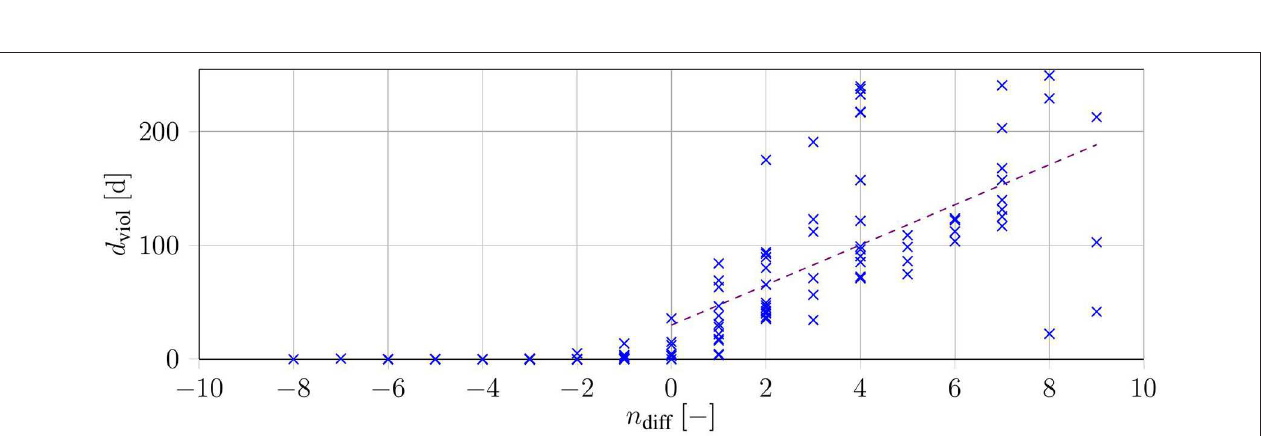
FIGURE 6 | Duration of constraint violation d viol over the difference in the number of treatments for each of the 140 test cases (blue). The purple dashed line shows a linear regression over all instances with n diff ≥ 0.